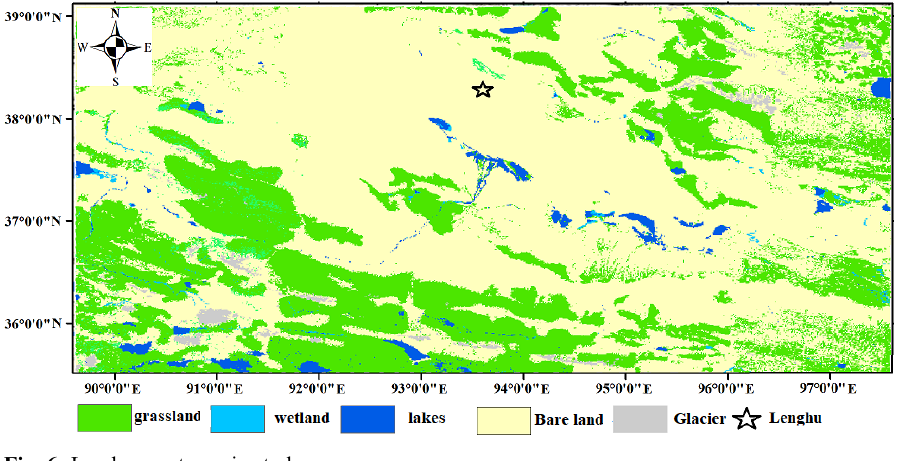
Fig. 6. Land cover types in study area.